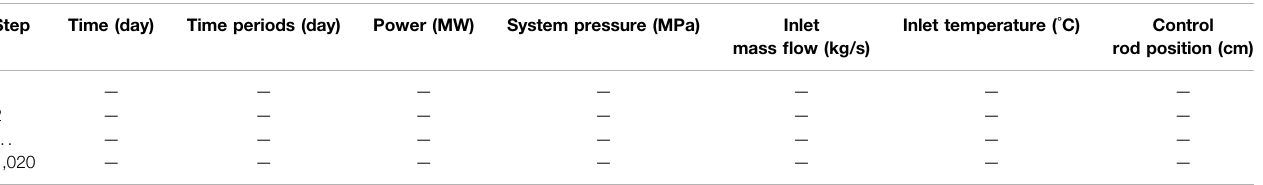
TABLE 2 | Input-parameter table used in PANGU simulation (example